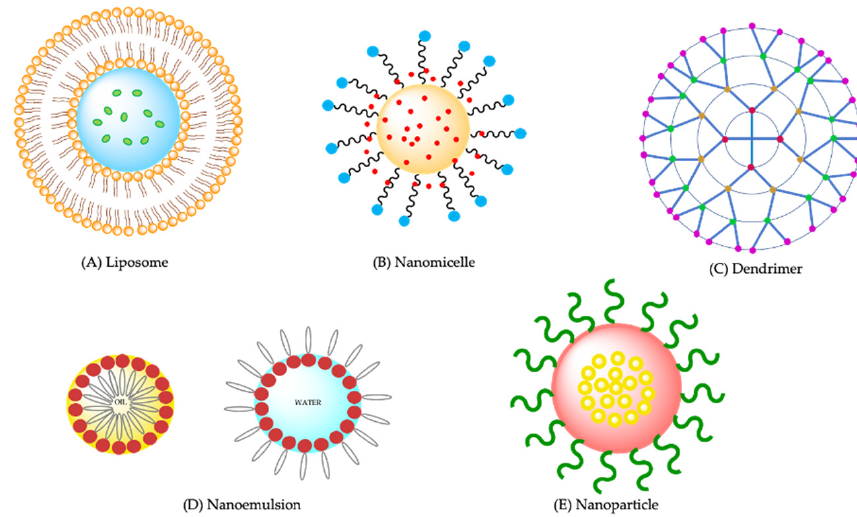
Figure 4. Schematic representation of common nanocarriers. ( A ) liposome; ( B ) Nanomicelle; ( C ) Dendrimer; ( D ) Nanoemulsion (oil-in-water type on the left-hand side; water-in-oil type on the right-hand side); ( E ) Nanoparticles (solid core surrounded by a surfactant layer). [authors own drawing].